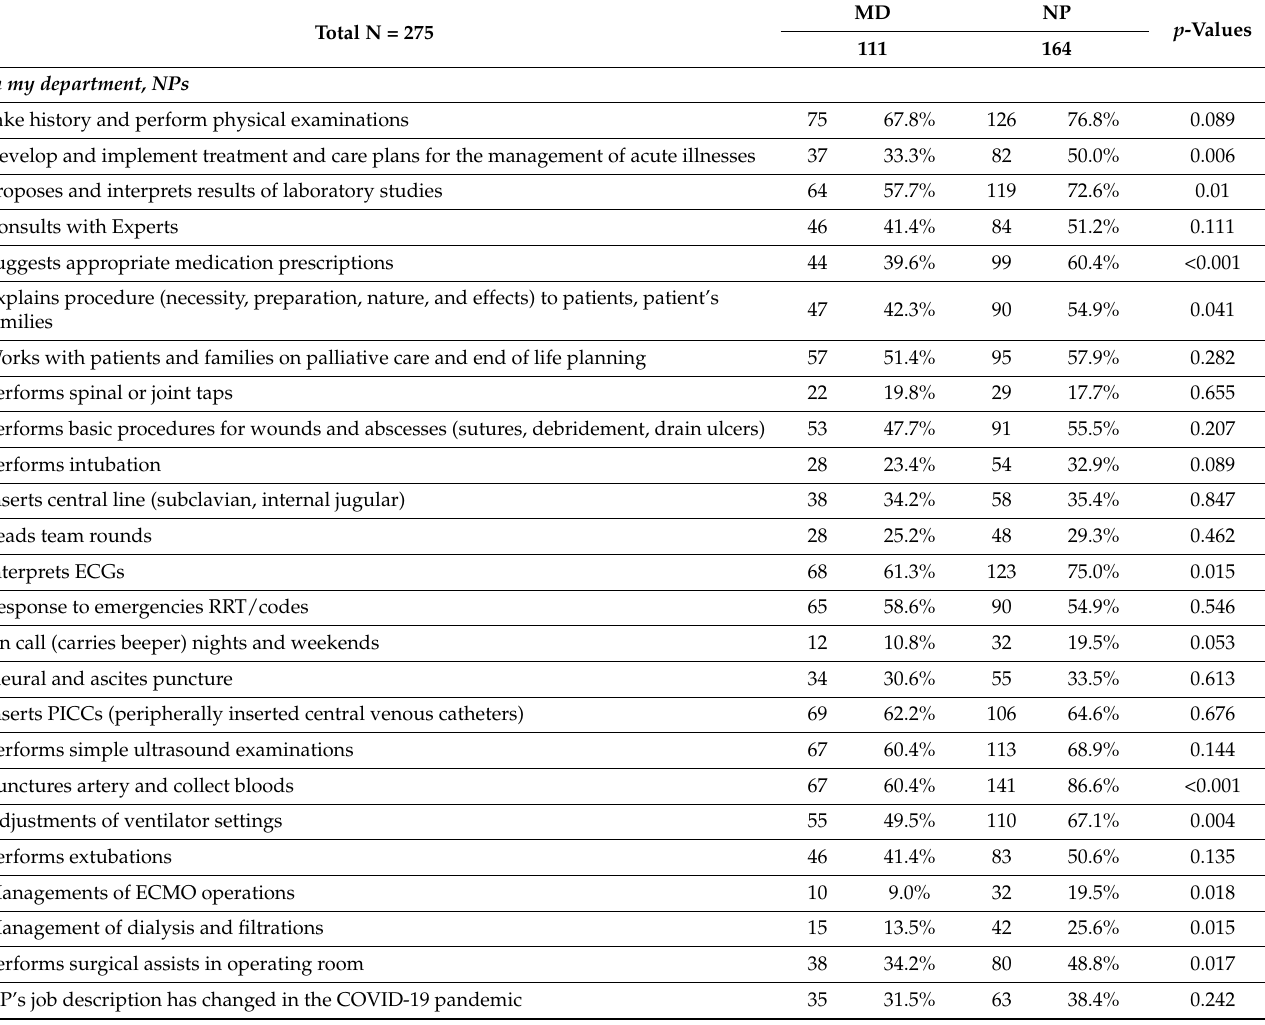
Table 2. NPs in Clinical Practice in